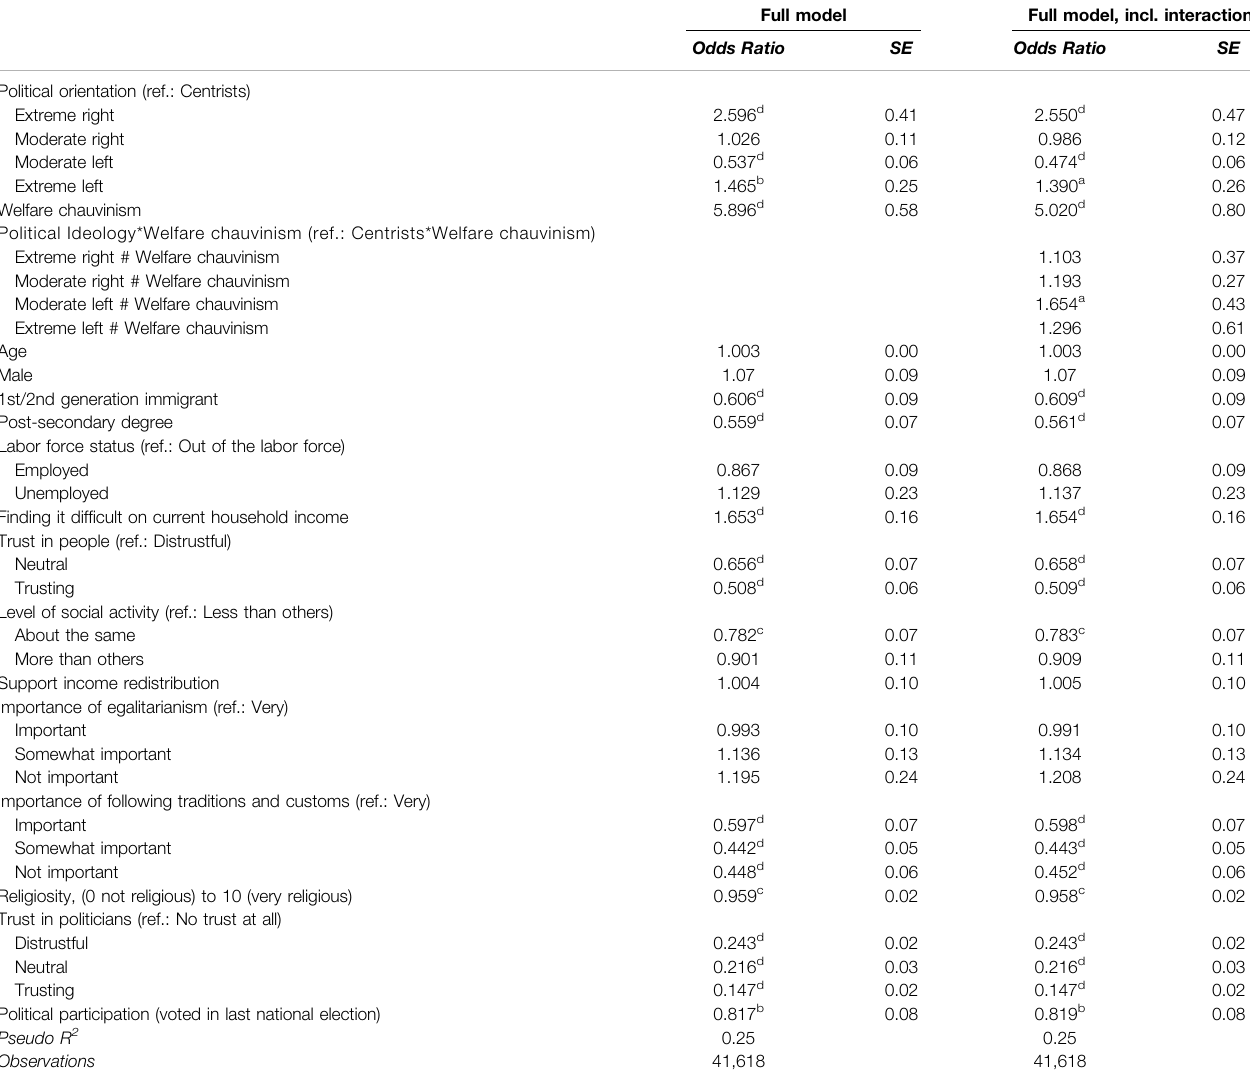
TABLE 3 | Results from logistic regression on extremely anti-immigrant attitudes, including a control variable measuring welfare chauvinism.